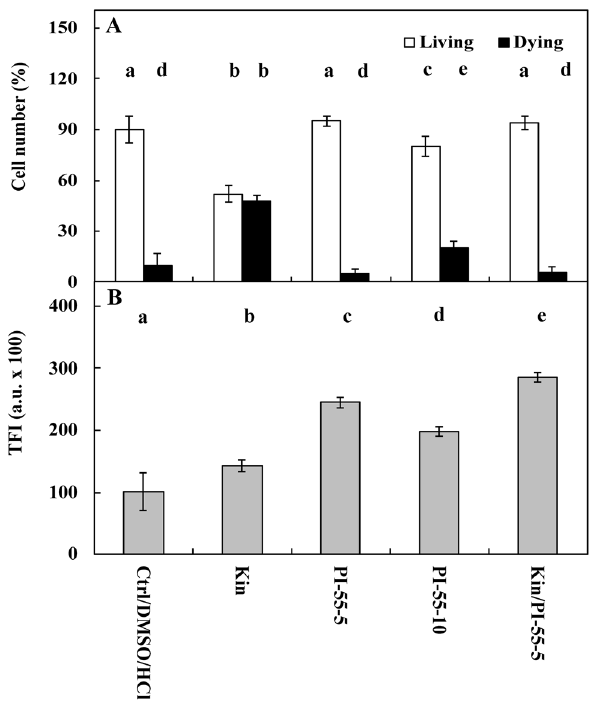
Figure 1. Number (%) of living and dying cells ( A ) and cytosolic calcium ion (Ca 2+ ) amounts ( B ) in Vicia faba ssp. minor cortex cells of seedlings of apical part of roots after treatment with PI-55, a specific blocker of cytokinin receptors. The number of living and dying cells as well as the amounts of Ca 2+ were fluorescently estimated after staining with acridine orange, ethidium bromide and chlortetracycline. Bars indicate ± SE of the results from three biological replicates. The means of the results with the same letter above the column are not significantly different at p ≤ 0.05. Ctrl, control; DMSO, dimethyl sulfoxide; Kin, kinetin; Kin/PI-55–5, kinetin with 5 μM PI-55; PI-55–5, 5 μM PI-55; PI-55–10, 10 μM